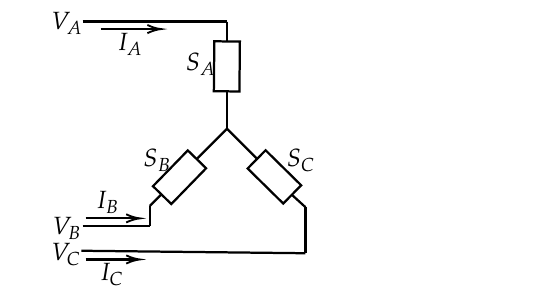
Figure 3. Wye connection.